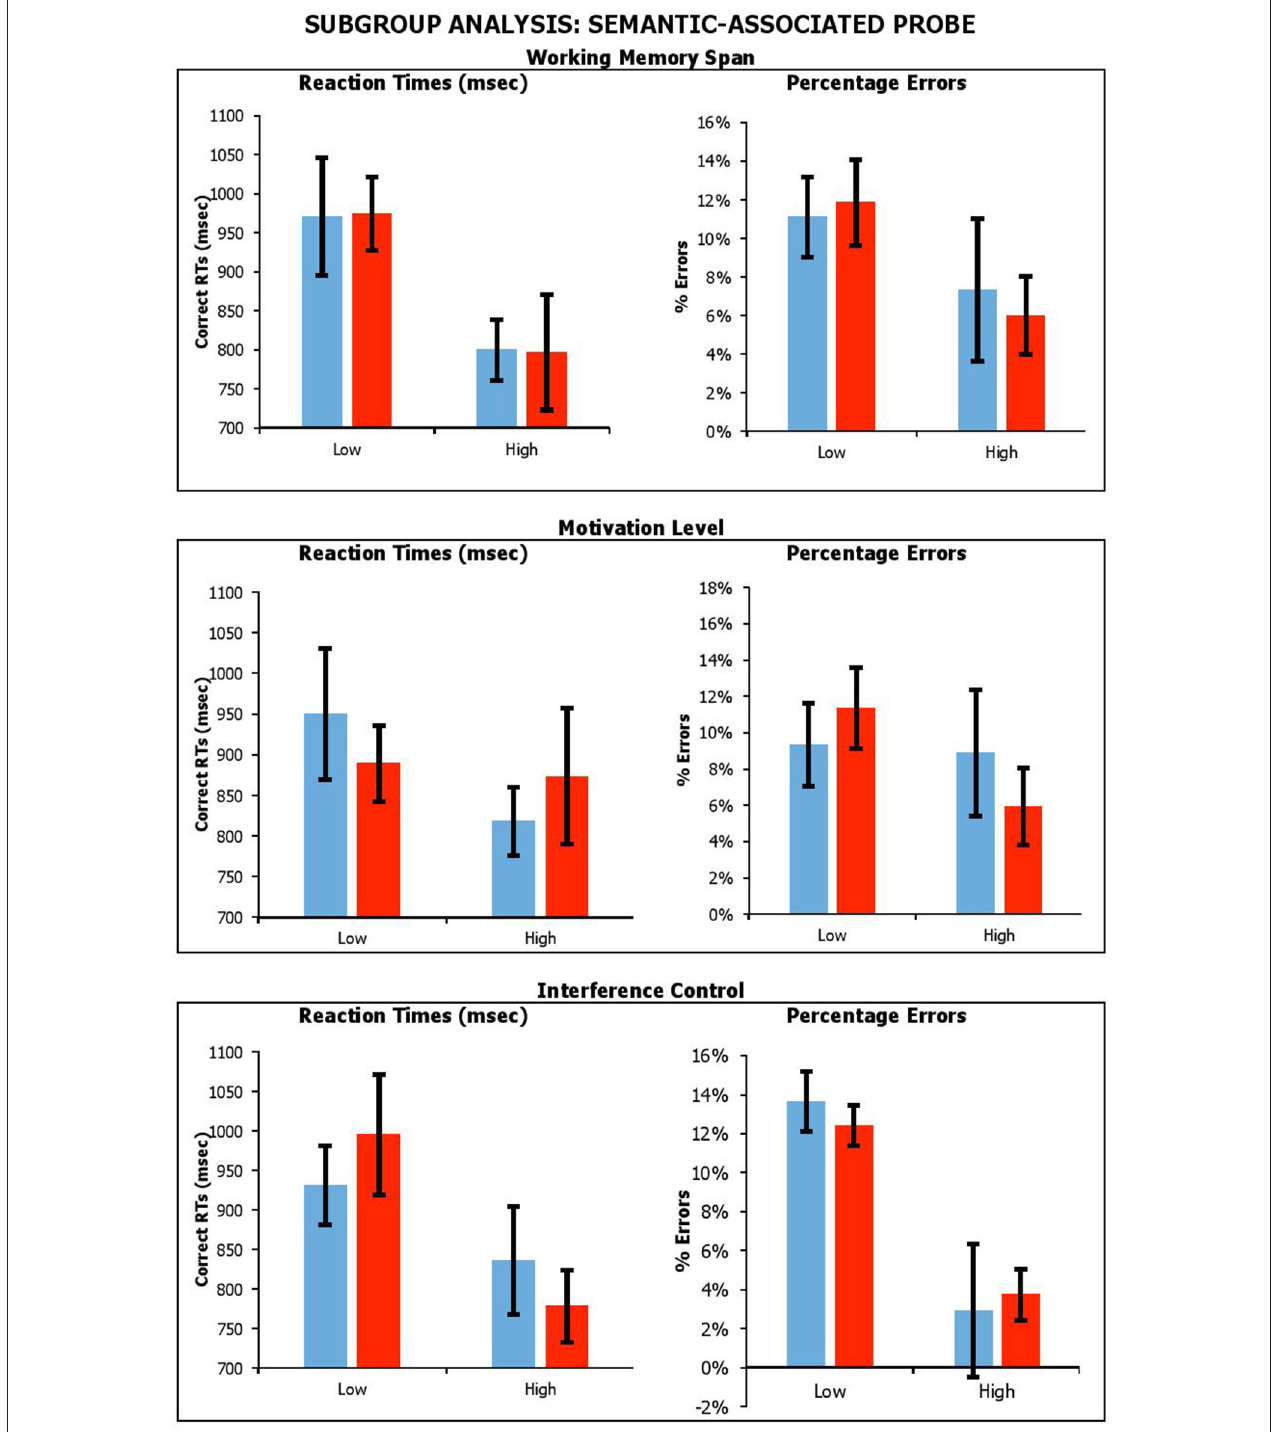
FIGURE 7 | Performance on lure trials (i.e., average of negative-associated, negative-combined and negative associated-combined) in semantic-associated probe across stimulation conditions, with participants divided by Working Memory Span; Motivation Level; and Interference Control. Error Bars indicate Standard Error.